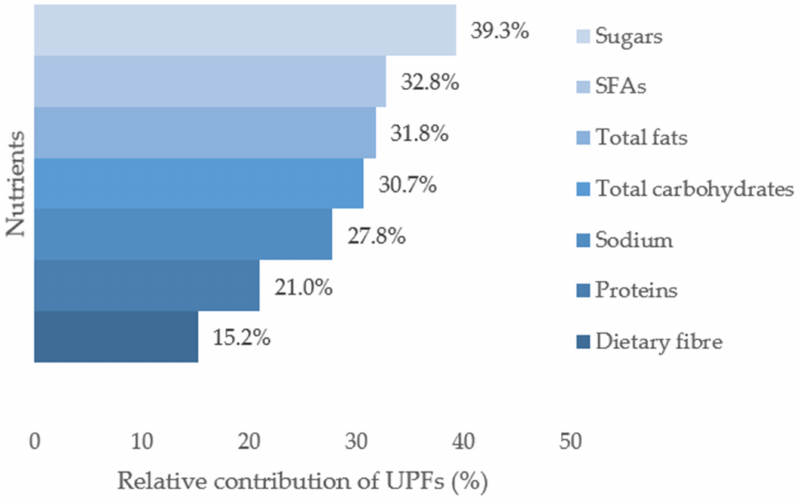
Figure 2. Relative contribution of UPFs to total daily intake (% based on medians) for seven nutrients. Sugars include all mono and disaccharides, e.g., glucose, fructose, lactose, saccharose; SFAs: saturated fatty acids.